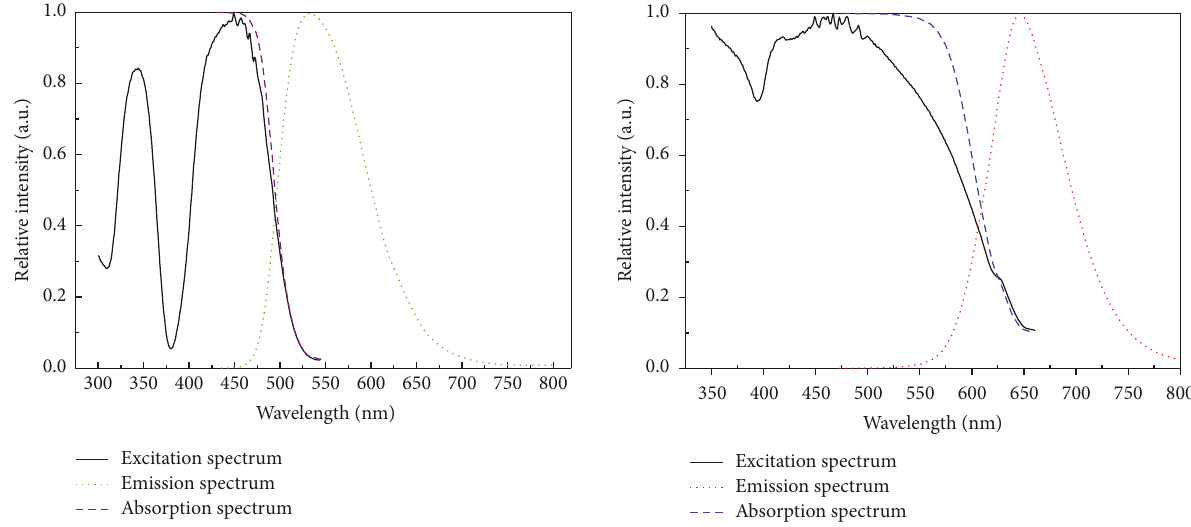
Figure 5: Experimental excitation, emission, and calculated absorption spectrum of green and red phosphors.